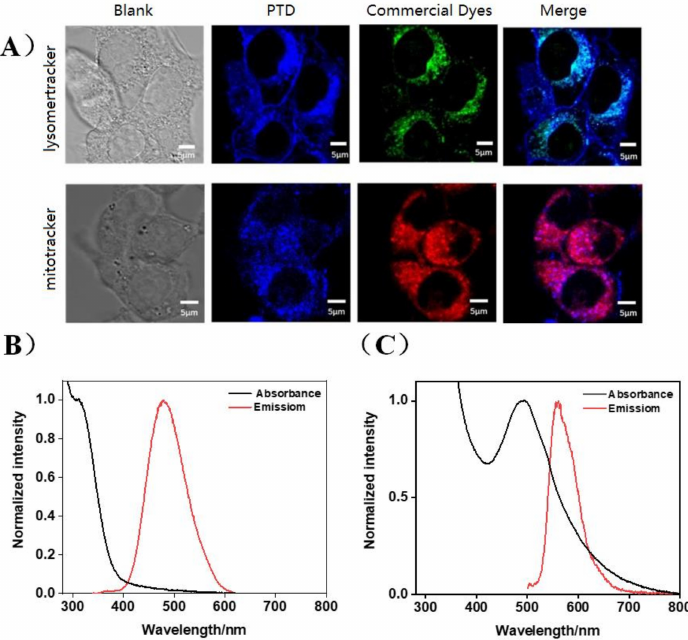
Figure 5. ( A ) The fluorescence image of PTD polymer was observed by confocal laser scanning microscope; ( B ) normalized fluorescence spectrum of PTD; ( C ) normalized fluorescence spectrum of DOX-loaded